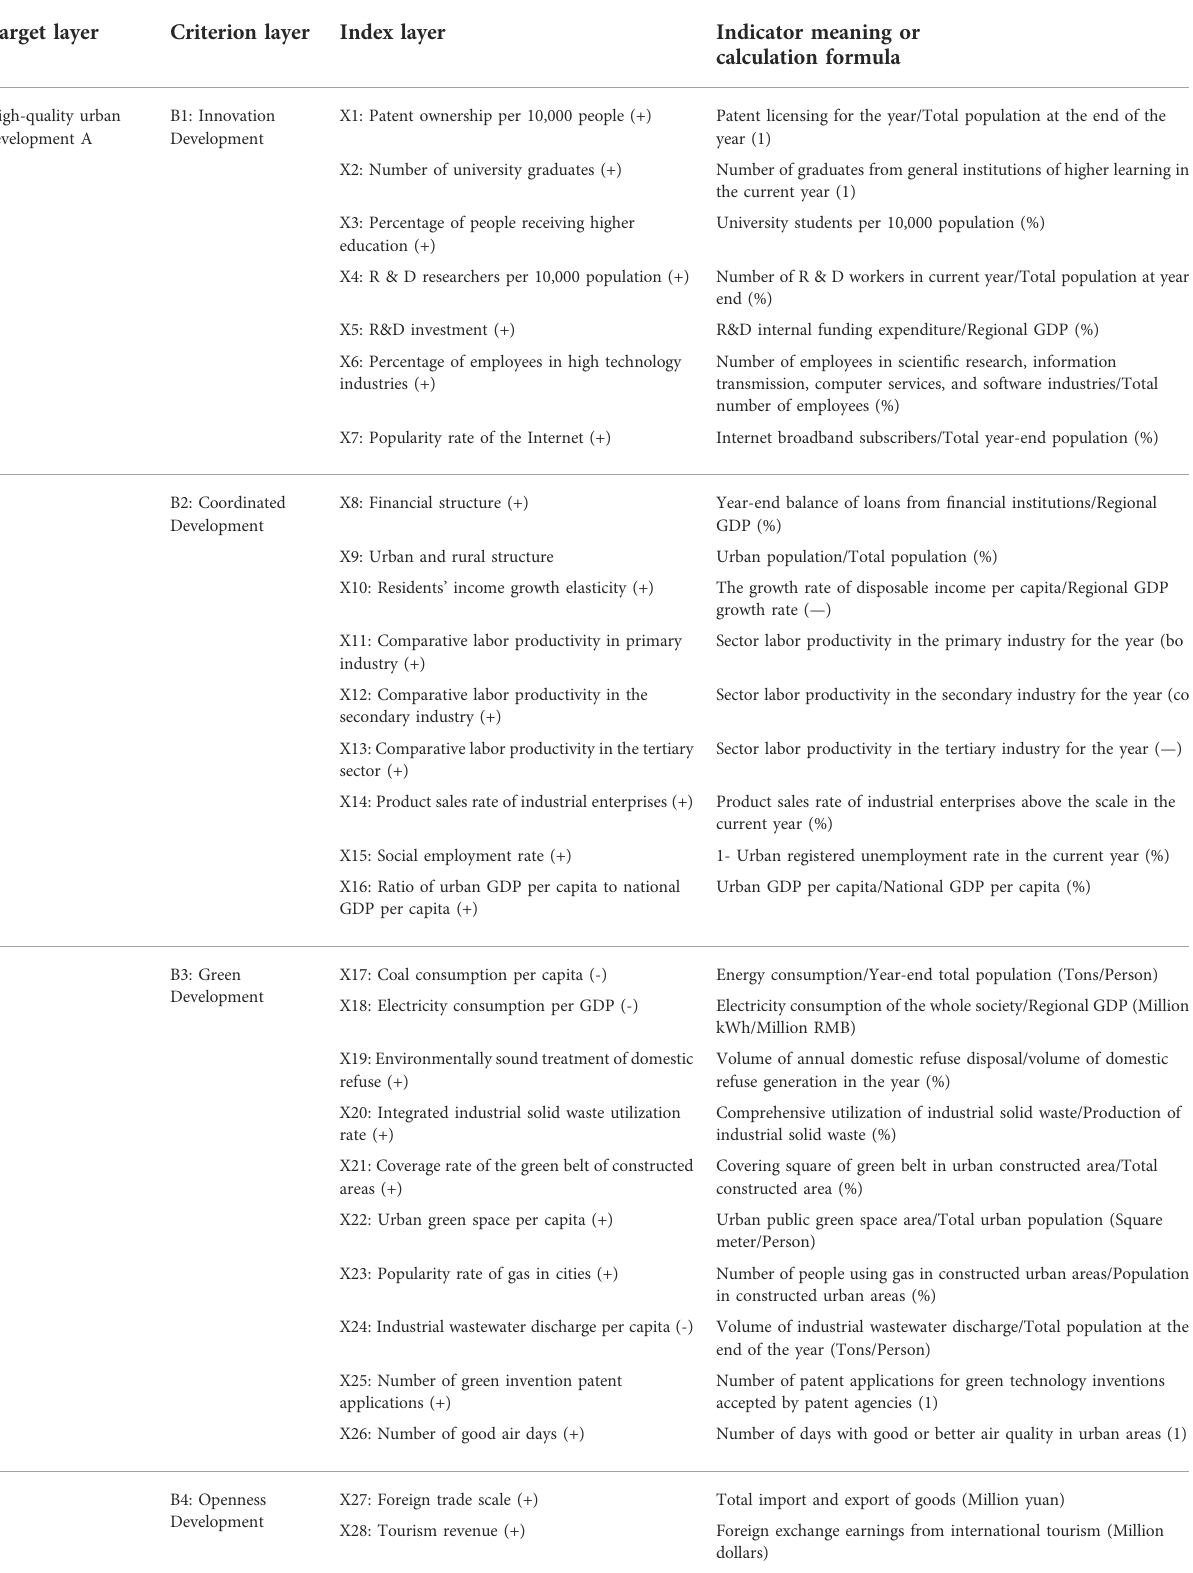
TABLE 1 Index system for measuring the level of HQD of cities in the